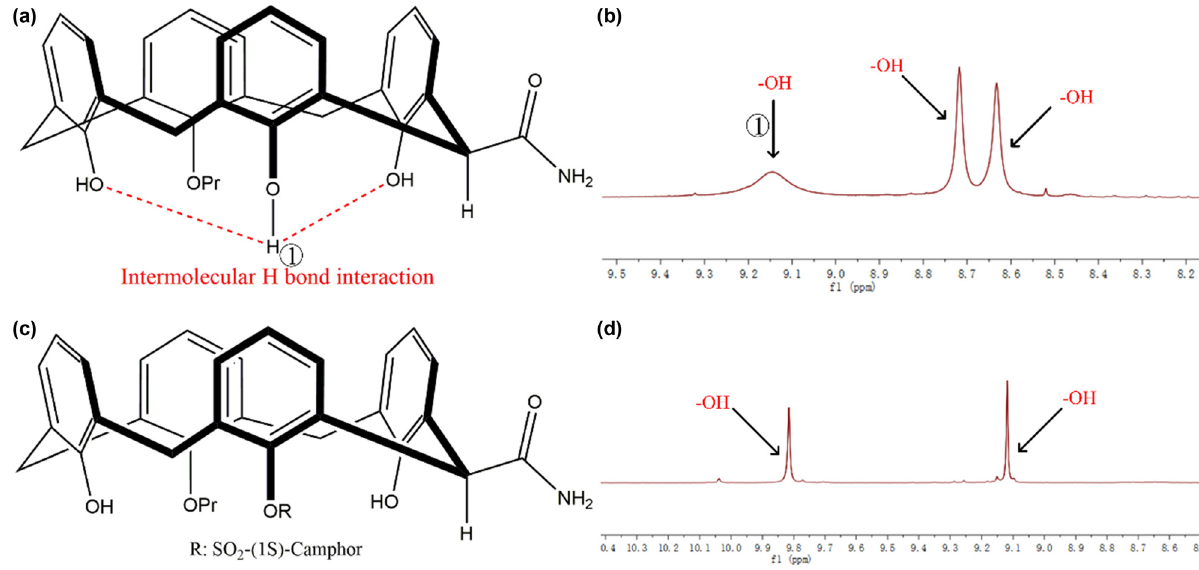
Figure 4: The chemical shift and peak characteristics of hydroxyl functional groups in compounds 2 and 3a : ( a ) shows the structure of compound 2 , ( b ) shows the hydroxyl peak in compound 2 , ( c ) shows the structure of compound 3a , and ( d ) shows the hydroxyl peak in compound 3a